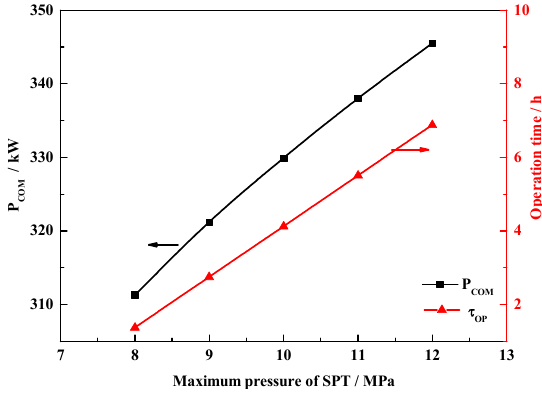
Figure 11. Effect of SPT maximum pressure on P COM and operation time.